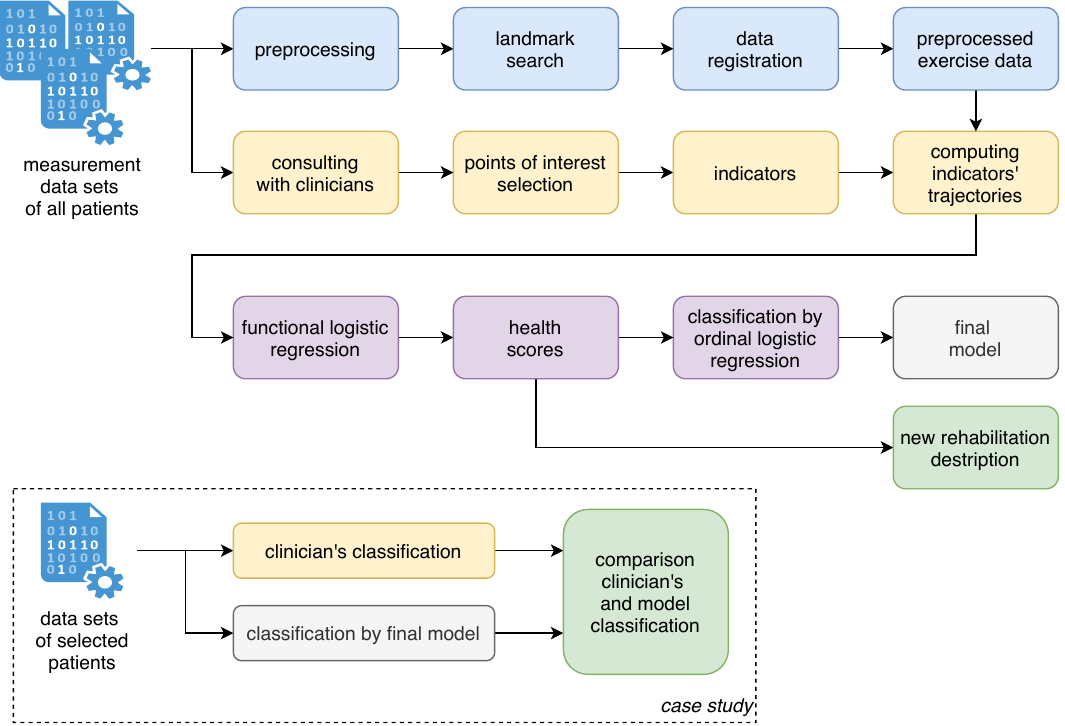
Figure 3. Scheme of analysis steps and main